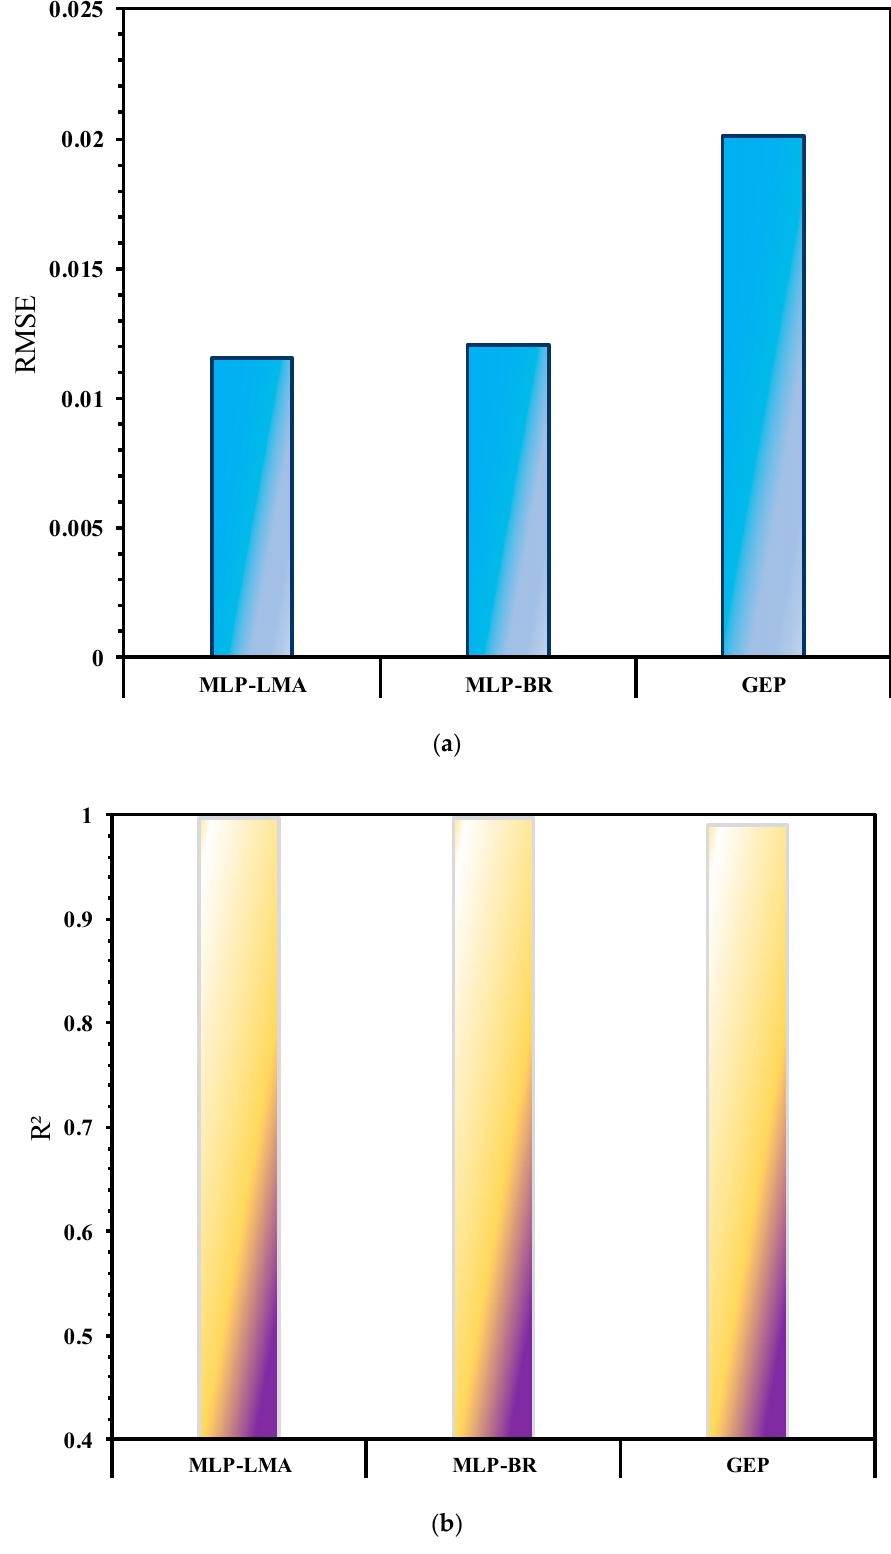
Figure 2. Performance comparison on the overall dataset for the proposed models: ( a ) Root mean square error (RMSE), and ( b ) R 2 .